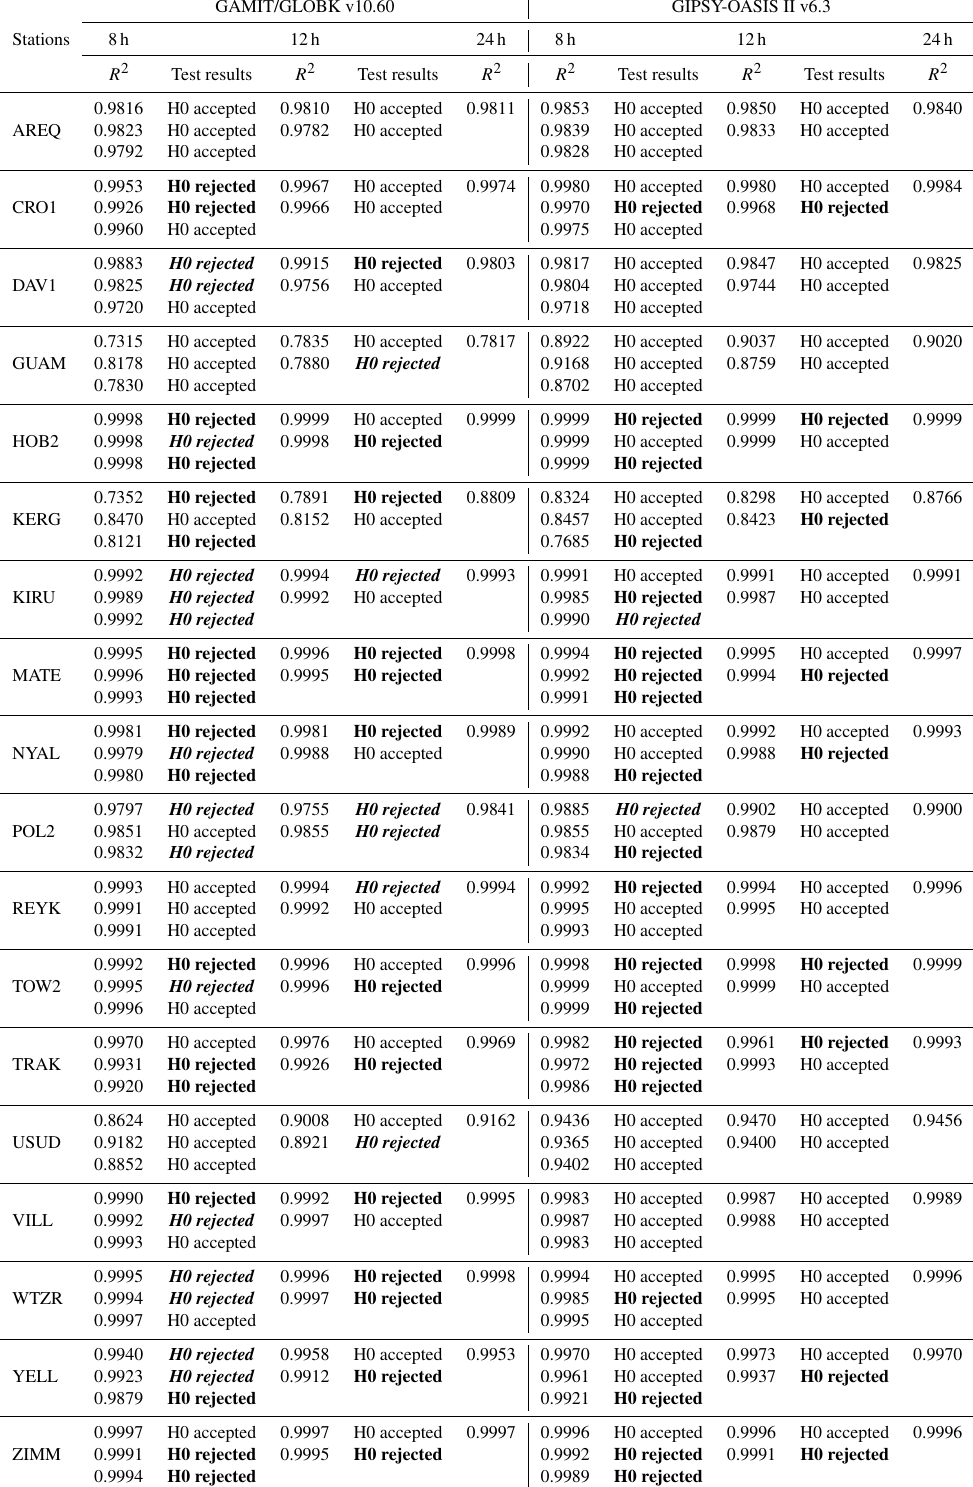
Table 3. For the north component, R 2 values and hypothesis test results for relative positioning and PPP. GAMIT/GLOBK